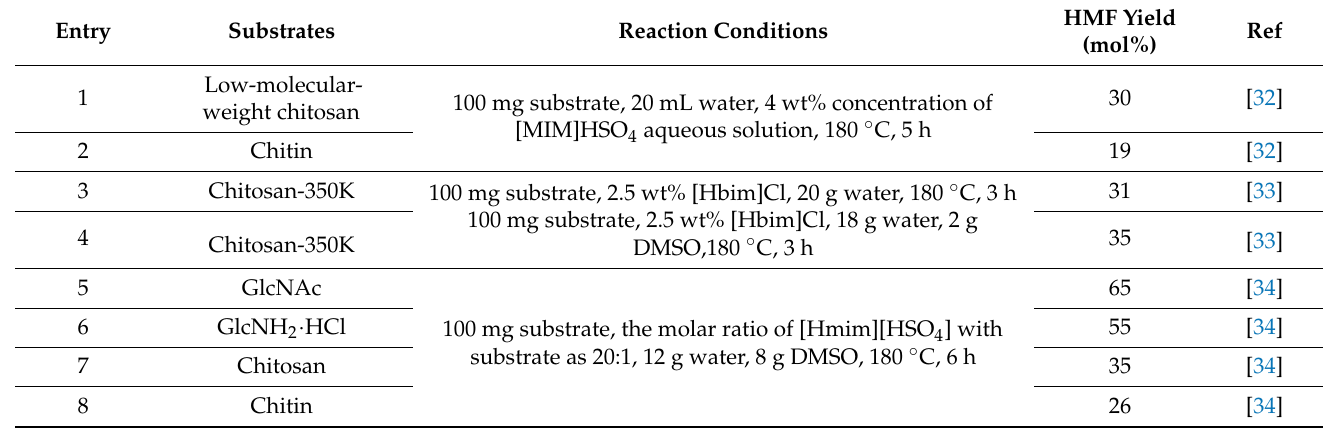
Table 3. Catalytic conversion of chitin biomass to HMF over ionic liquid